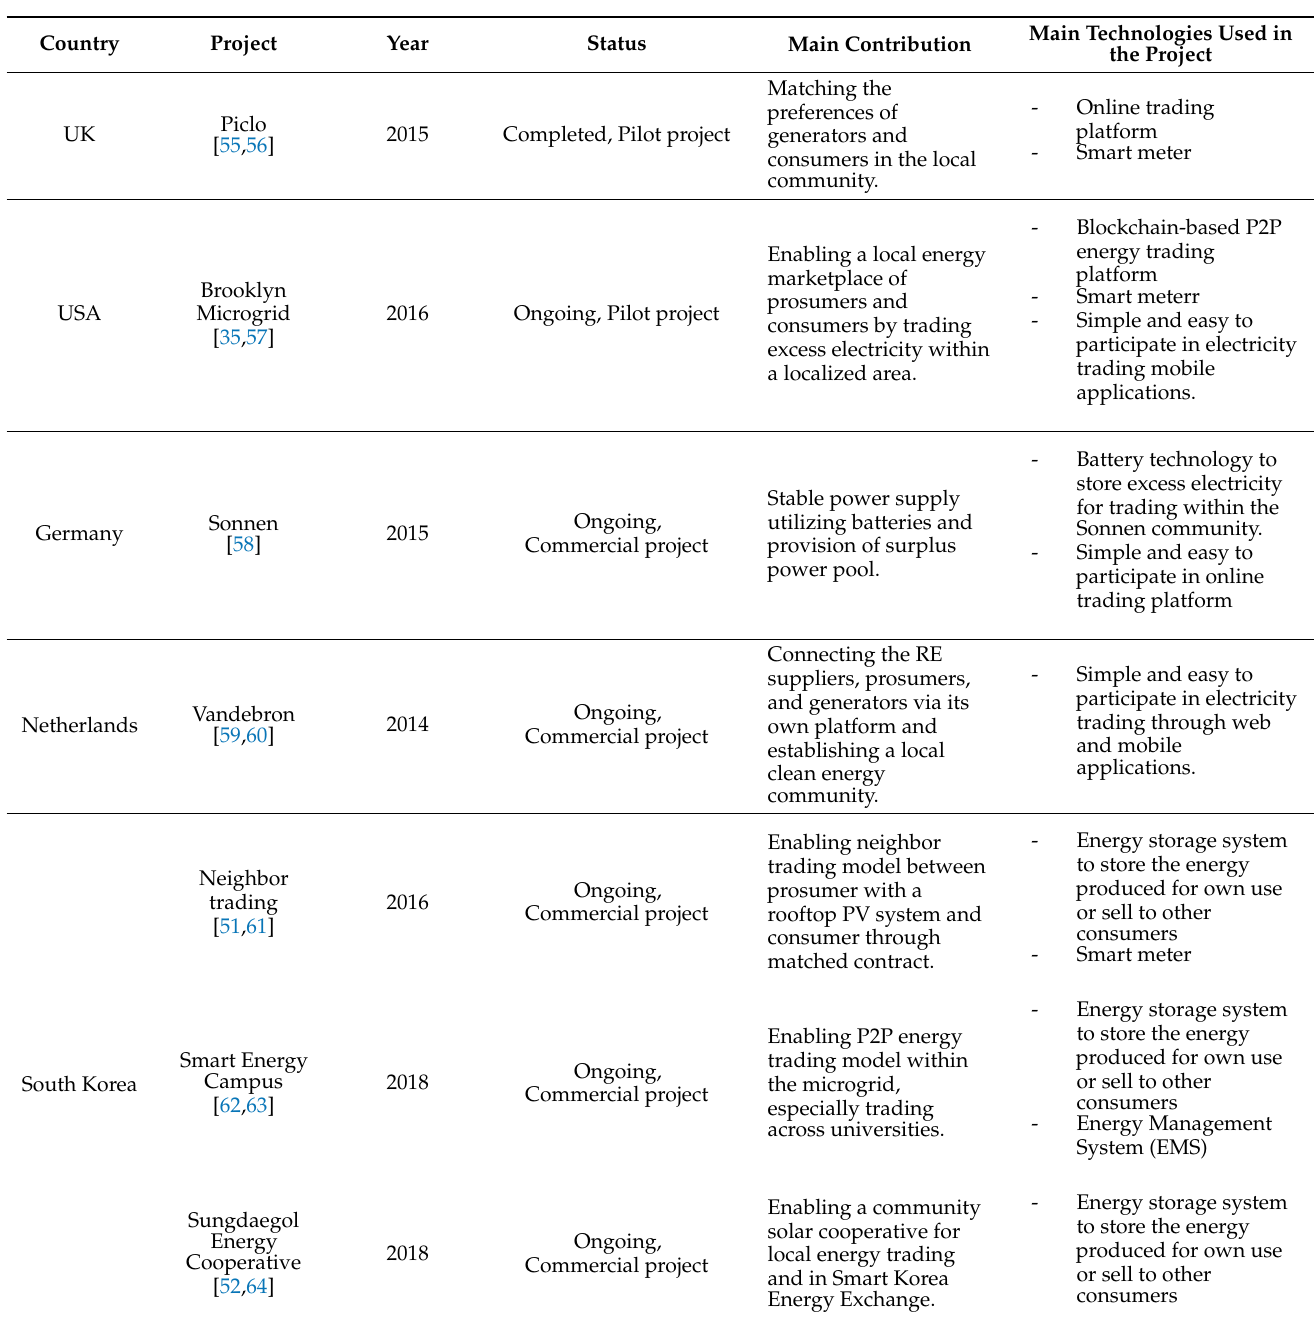
Table 1. P2P energy trading pilot and commercial